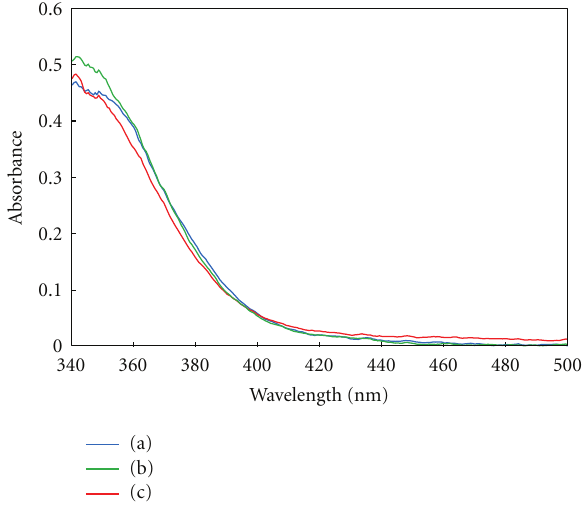
Figure 6: UV-Vis absorption spectra of (a) TiO 2 , (b) 1 mol% Sn/TiO 2 , (c) 1.5 mol% Sn/TiO 2 , (d) 3mol% Sn/TiO 2